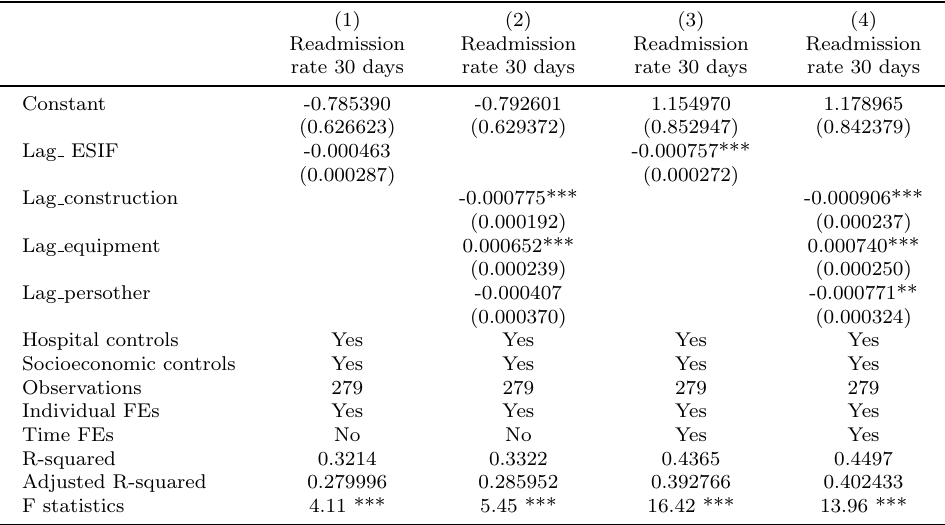
Table 4: Lagged effect of cumulative ESIF on the readmission